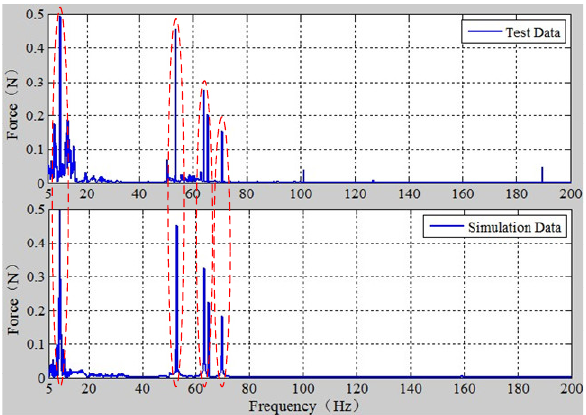
Figure 10. Test and simulation data comparison of Z-direction reaction force at O1 point.